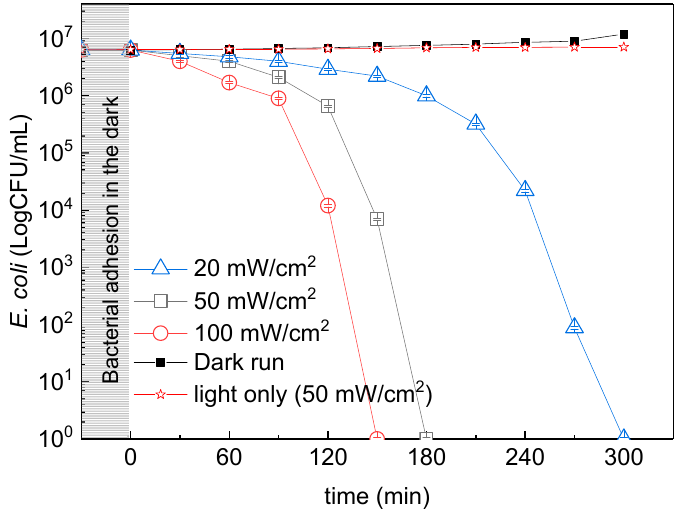
Figure 5. E. coli inactivation on ceramic tiles coated with 8% Ag-NPs–TiO 2 under different solar light intensities.